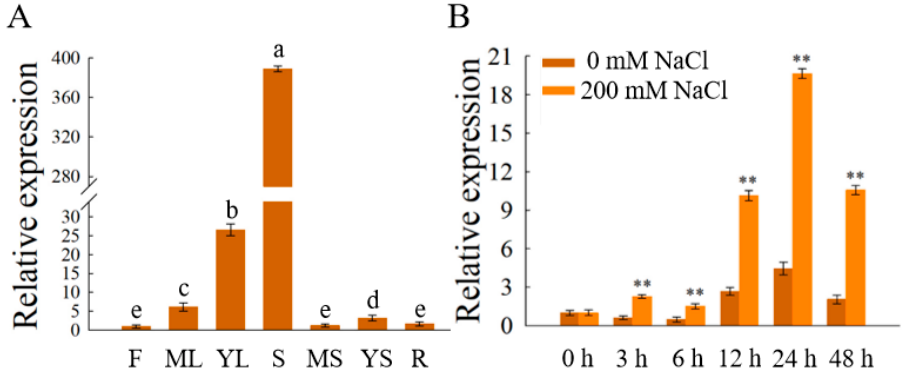
Figure 4. Expression of OfSPL11 . ( A ) Expression of OfSPL11 in various Osmanthus fragrans tissues. F indicates flowers, ML indicates mature leaves, YL indicates young leaves, S indicates shoots, MS indicates mature stems, YS indicates young stems, and R indicates roots. Different lowercase letters represent the significant differences as assessed by Duncan's test at the 0.01 level. ( B ) OfSPL11 expression levels in Osmanthus fragrans young leaves after 200 mM NaCl treatment. The internal reference gene for O . fragrans is OfACT and three biological re-reads were performed for each reaction. ** p < 0.01 were used to determine statistical significance.